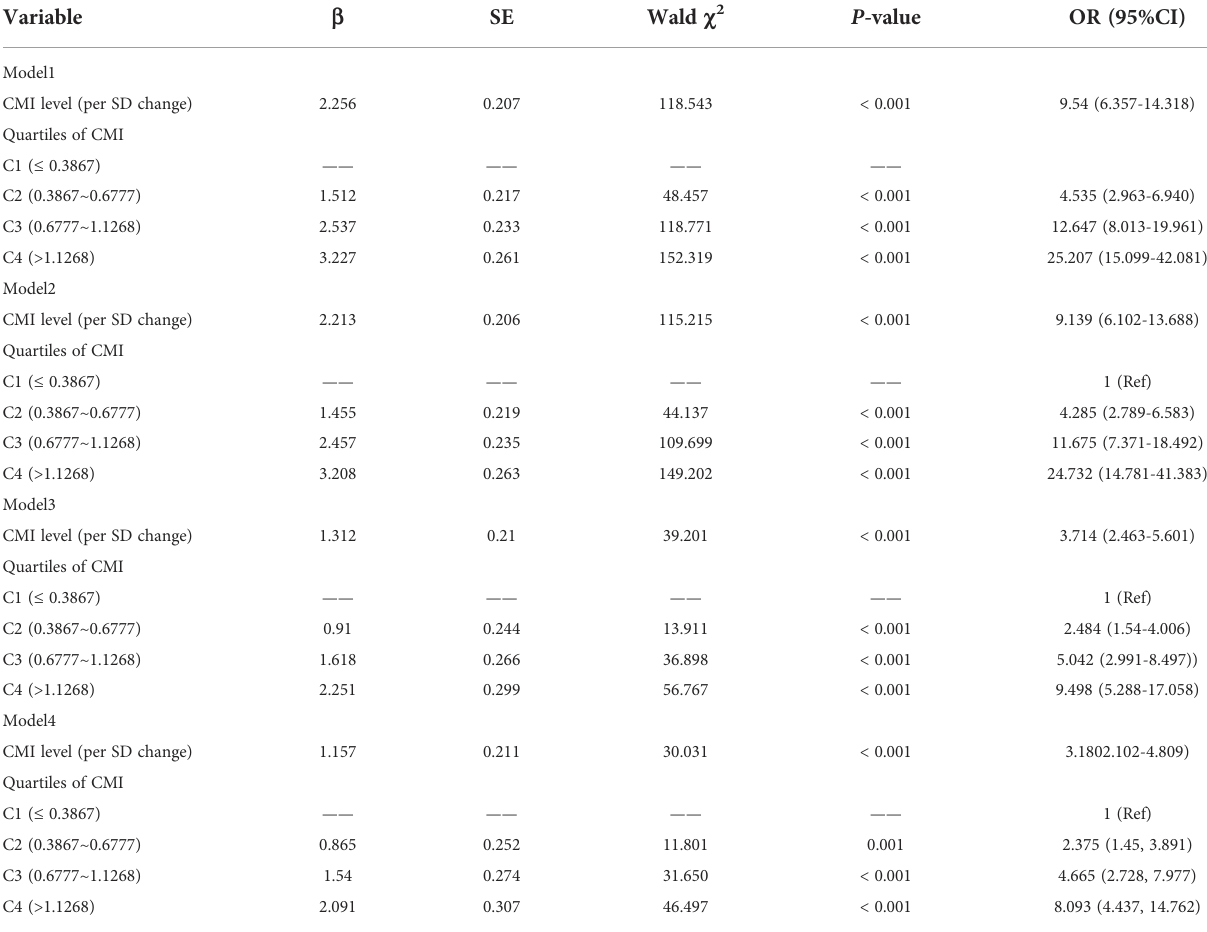
TABLE 2 Multivariate logistic regression of CMI for MAFLD.